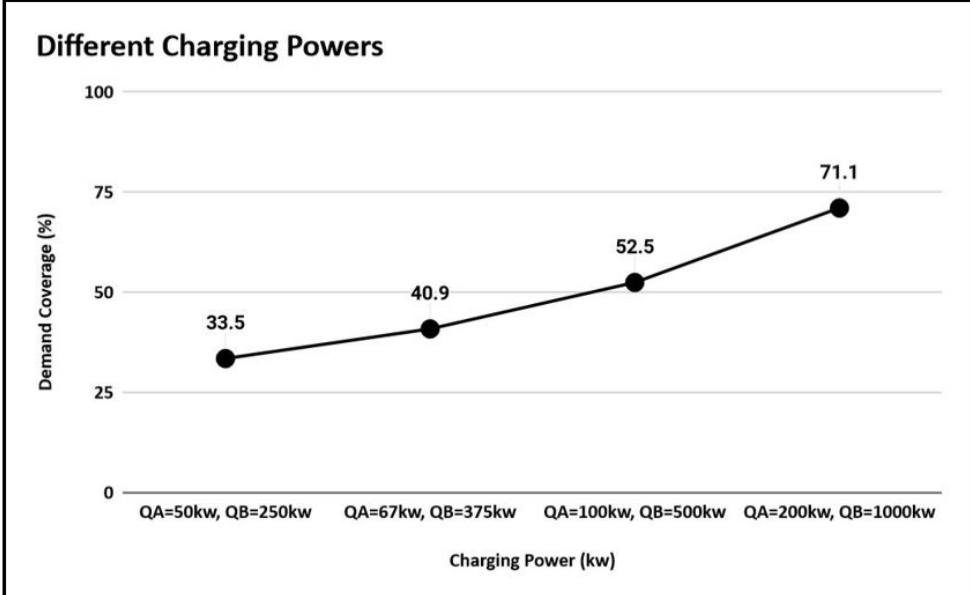
Figure 8. Demand coverage with different charging